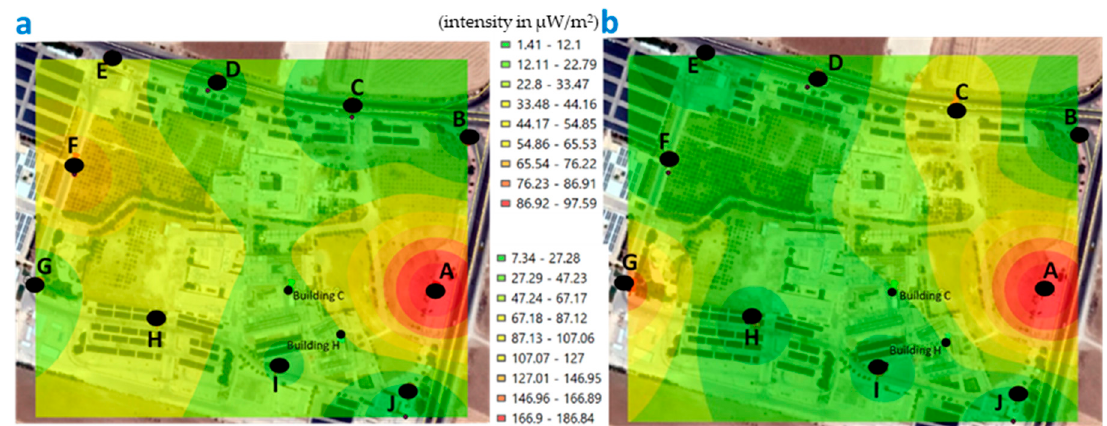
Figure 12. Map georeferenced with the levels of exposure recorded around the university area of GJU, in the afternoon (points A–J). ( a ) weekend and ( b ) during the week ( μ W/m 2 ).